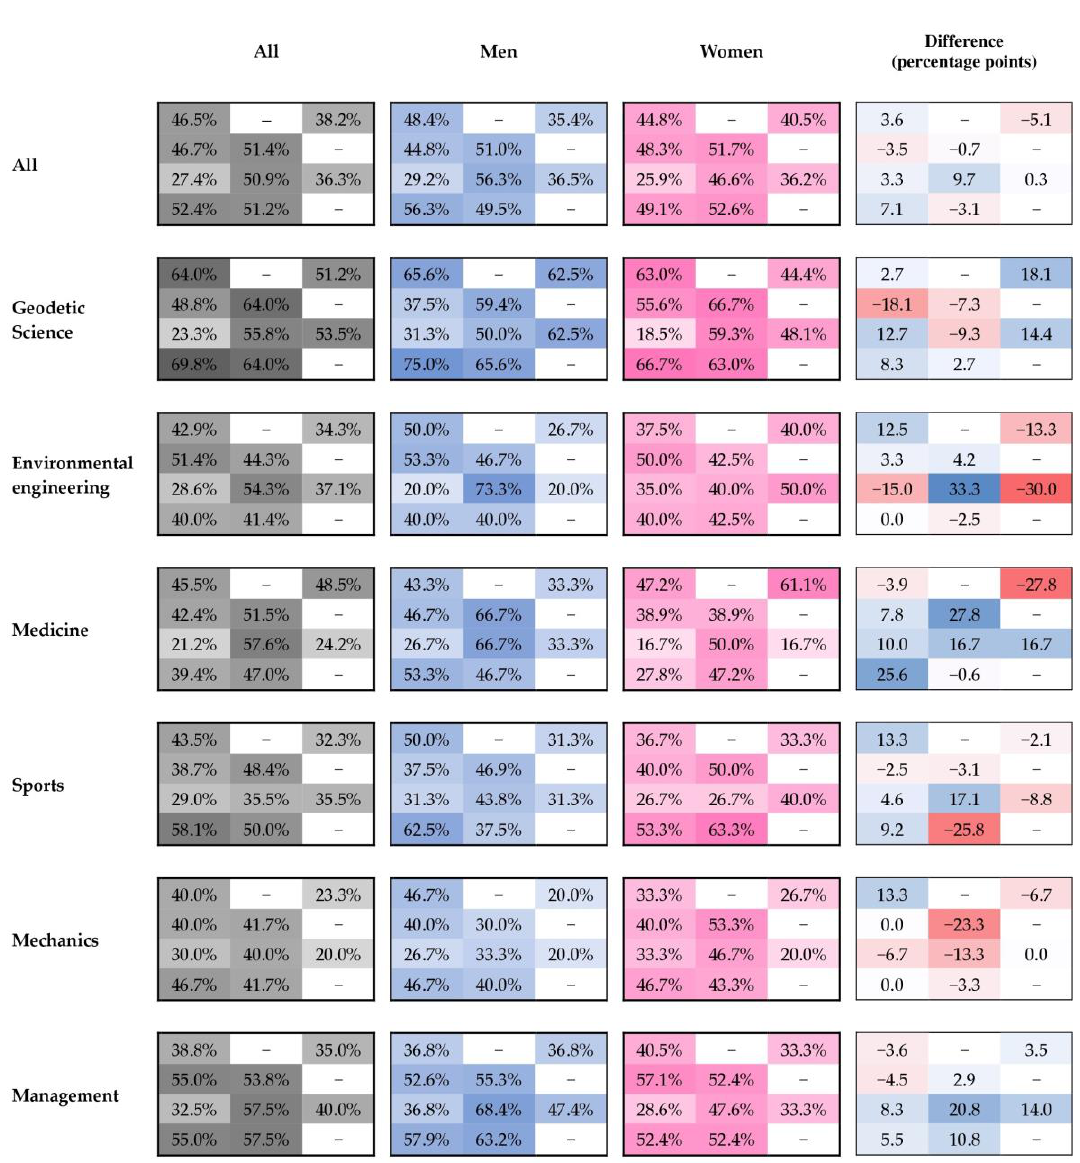
Figure 8. Diagram according to which the effect of the visualization parameters on the correctness of the determination of the right assigned to the property was analyzed (question numbers are given in the cells).